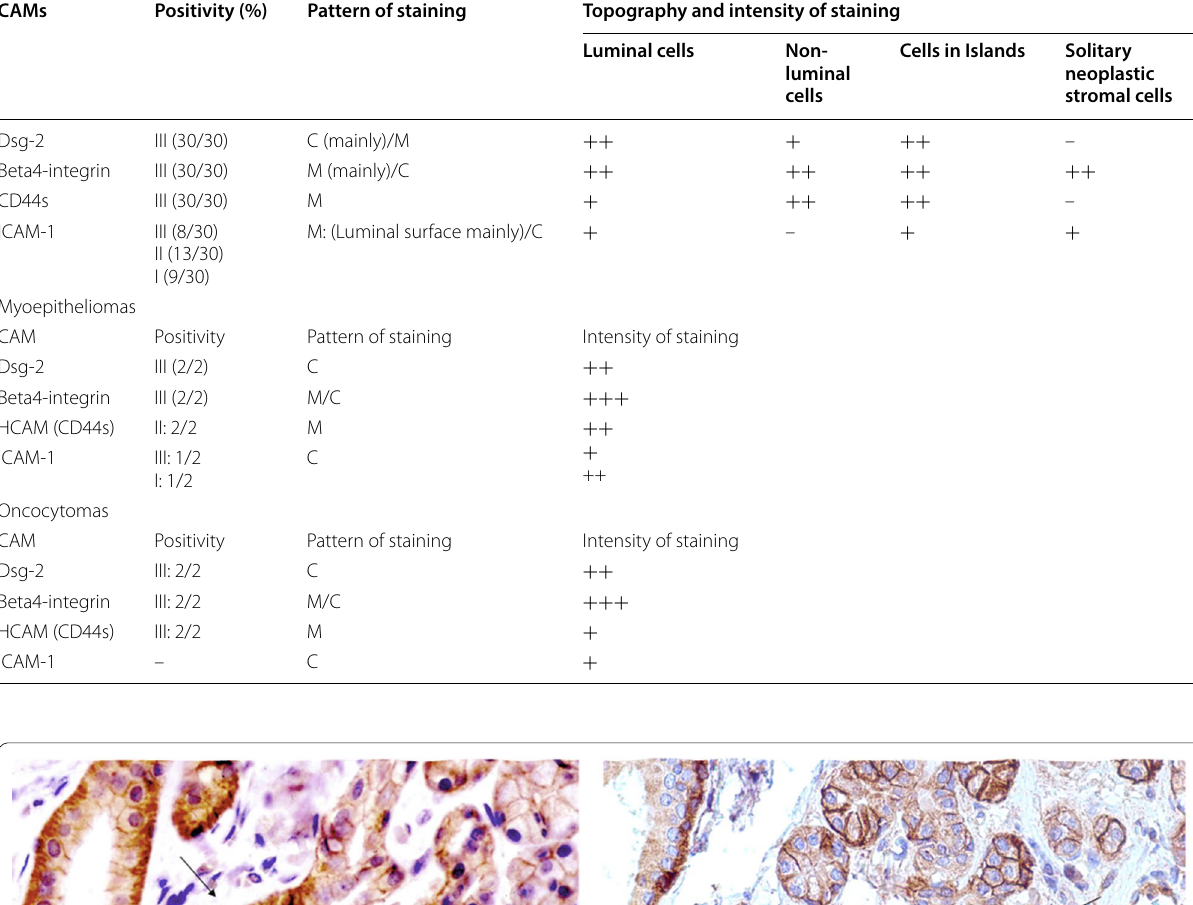
Table 2 Expression of cell adhesion molecules in benign SGTs CAMs